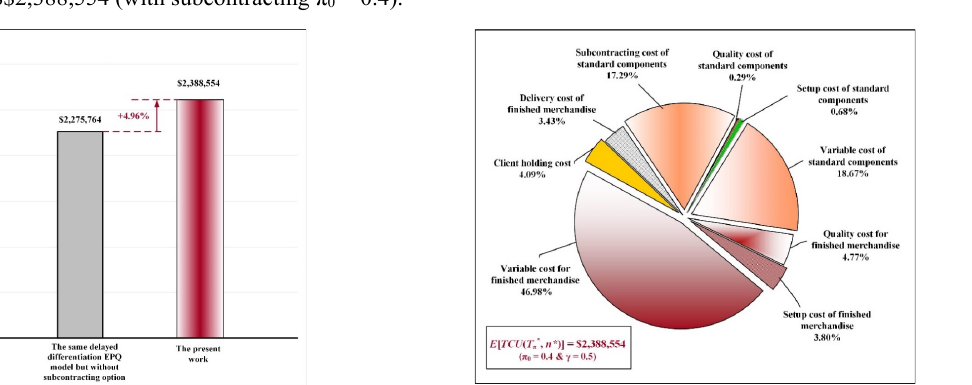
Fig. 12. The difference in E [ TCU ( T π *, n *)] for the system with and without subcontracting